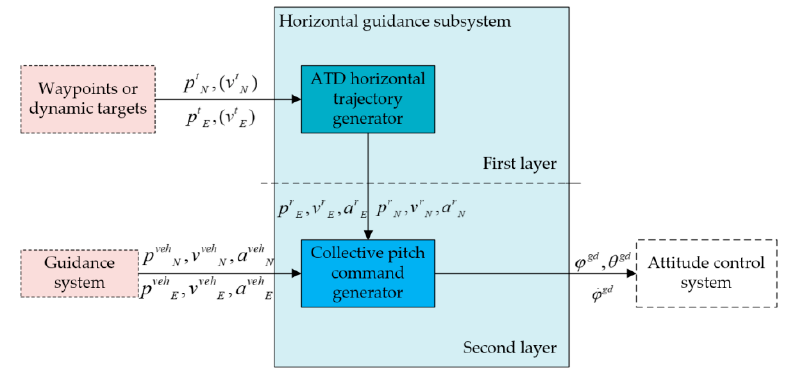
Figure 10. Diagram of horizontal guidance